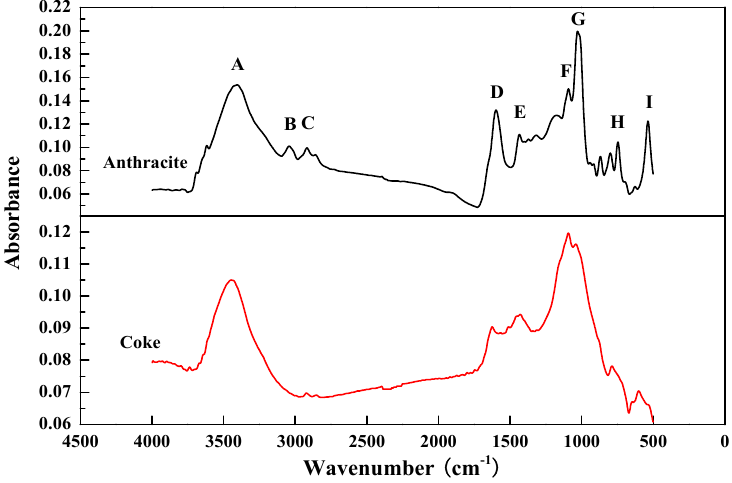
Figure 3. Fourier infrared spectra of anthracite and coke.